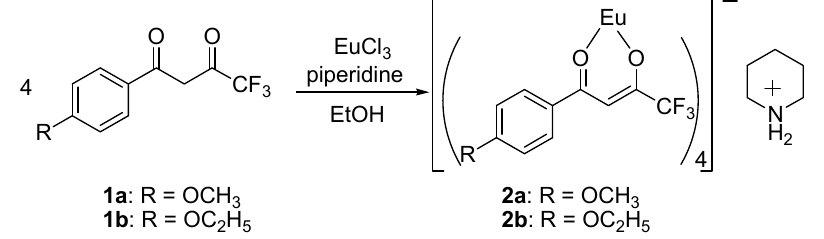
Table 2. Selected bond lengths (Å) and angles (°) for the complex 2b